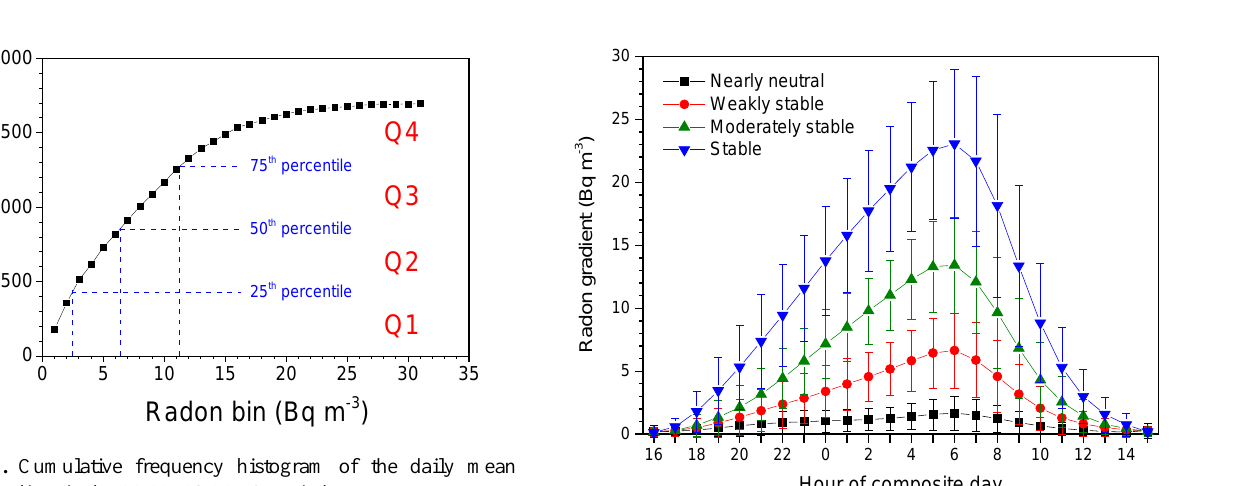
Figure 5. (a) Monthly means of the interpolated (“non-local”) and pseudo-gradient (diurnal) radon time series, and (b) diurnal composite plot of the gradient data.